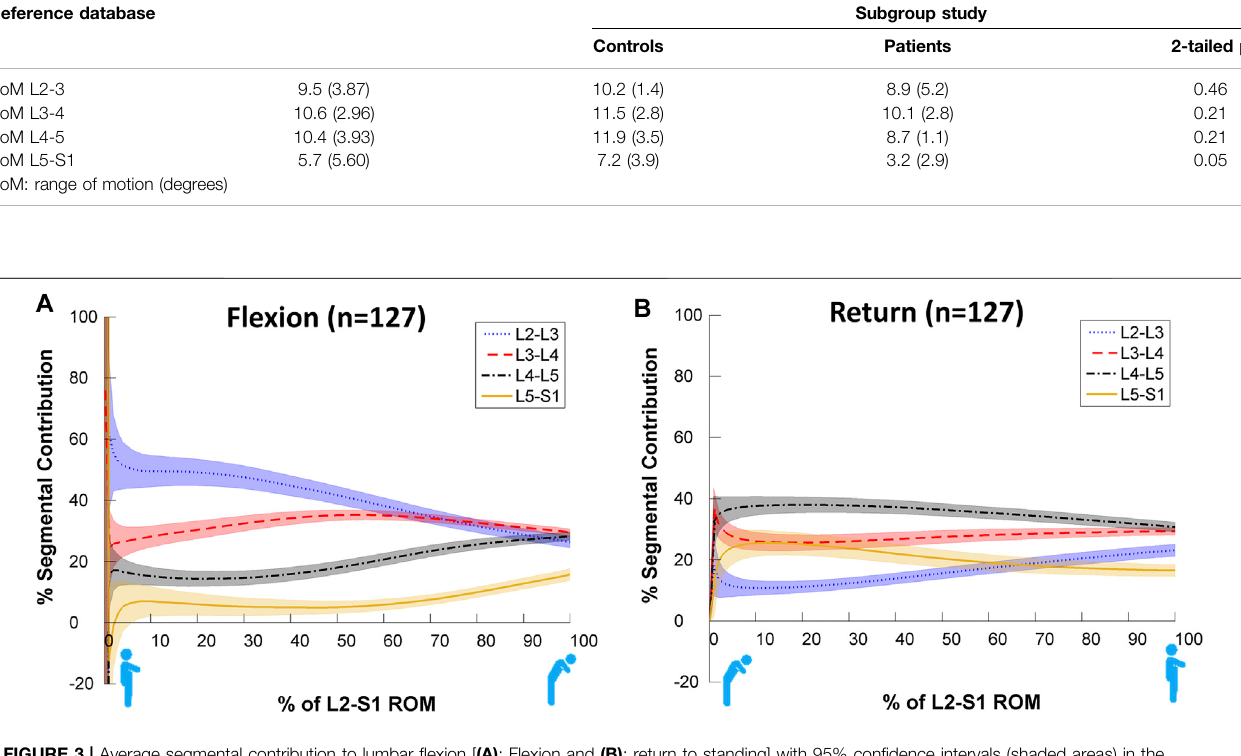
Frontiers in Bioengineering and Biotechnology |